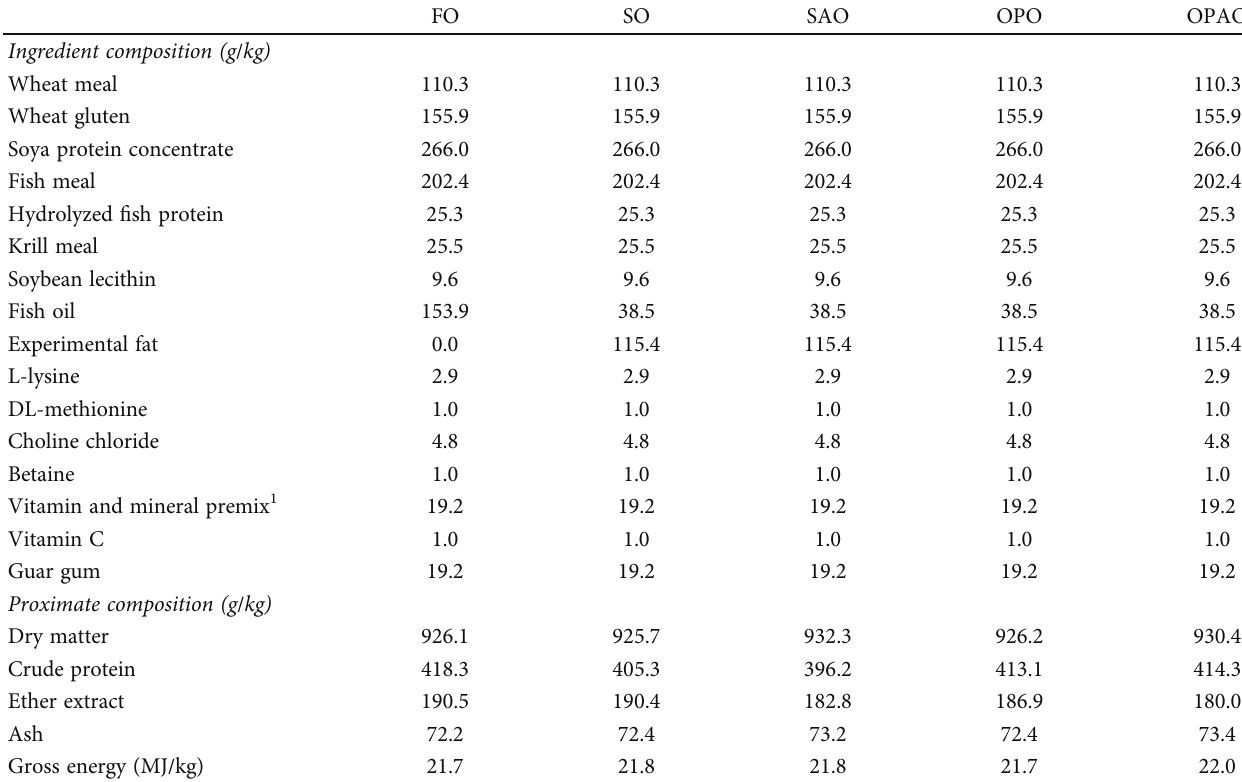
Table 2: Ingredients, proximate composition, and gross energy of the fi ve diets used in this study. FO SO SAO OPO OPAO 110.3